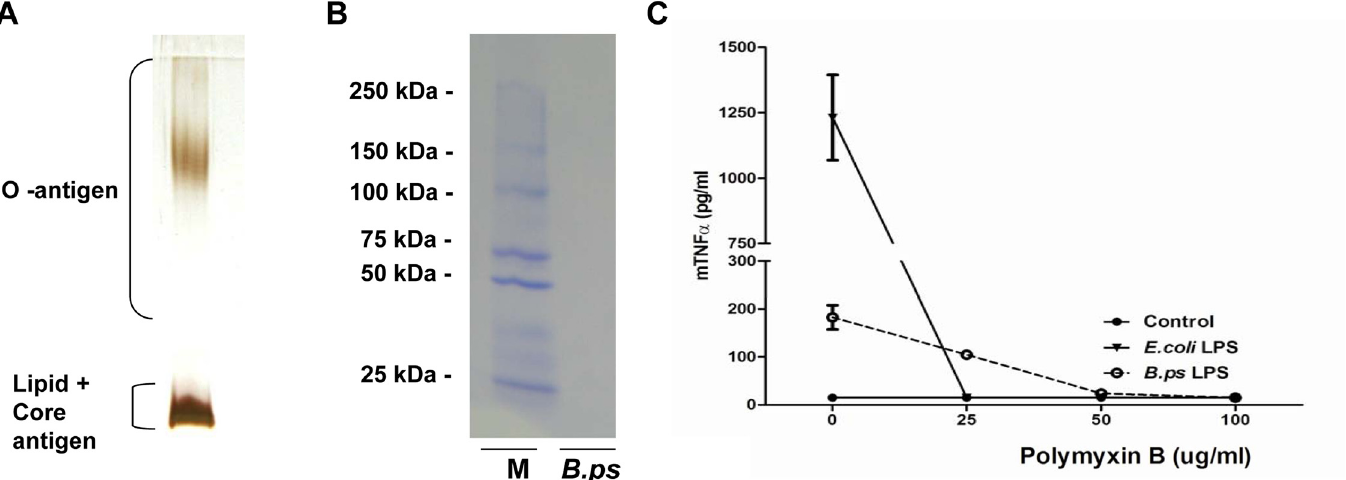
Fig 1. Successful extraction and purification of B . pseudomallei- LPS. LPS from B . pseudomallei 1026b was purified by a modified hot phenol-water extraction method including proteinase K treatment. 10 μ l of LPS (0.5 mg/ml) was fractionated by SDS-PAGE electrophoresis followed by silver staining (A) which showed the characteristic ladder pattern of LPS banding of Gram-negative bacteria, without any indications of protein contamination (detection limit of 0.5 – 5 ng) and Coomassie blue staining (B) which demonstrated no protein contamination as well (detection limit 50 ng). Contamination of the extracted LPS was also assessed by the addition of LPS-binding Polymyxin B (PMB) (C). For this purpose, the murine alveolar macrophage cell line MH-S was stimulated with RPMI 1640 medium [56], LPS of E . coli 0111:B4 or B . pseudomallei 1026b and incubated with increasing concentrations of PMB for 6h, followed by TNF- α measurement in the supernatant. Results are representative for three independent experiments. (M = ladder, B.ps = B . pseudomallei